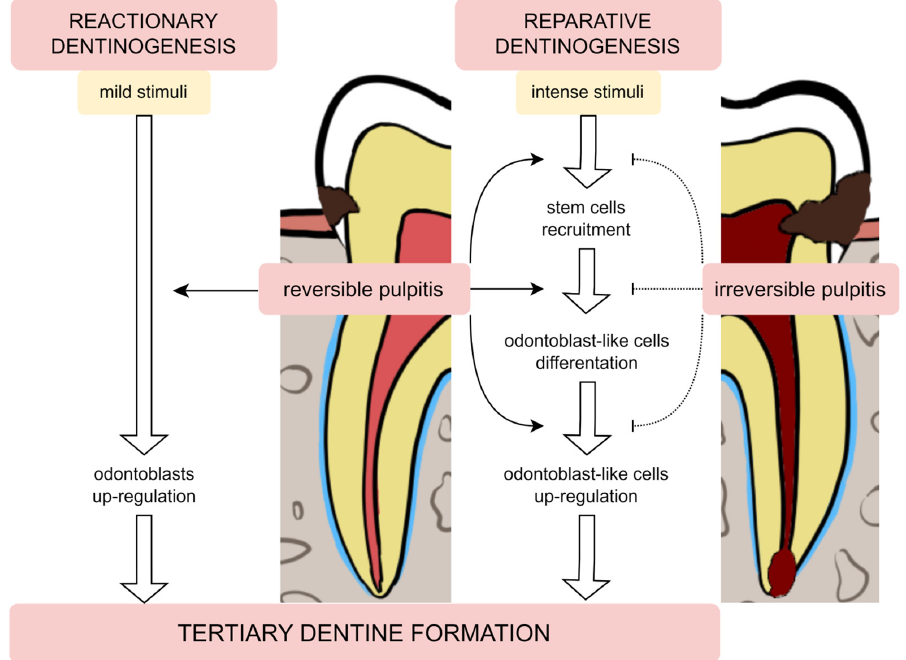
Figure 1. The tertiary dentine formation—reactionary and reparative dentinogenesis during reversible and irreversible pulpitis.